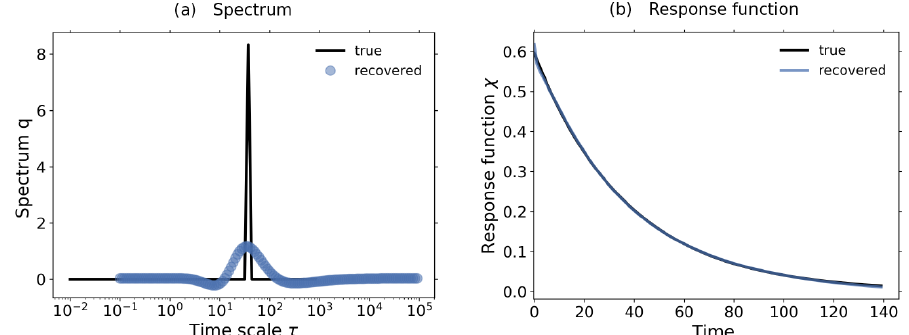
Figure E1. Spectrum q λ and response function χ(t) recovered from a 1% experiment performed with the toy model described in Part 1 taking an underlying discrete spectrum with one timescale τ = 37. The data were taken with SNR ∼ O ( 10 4 ) − O ( 10 5 ) .